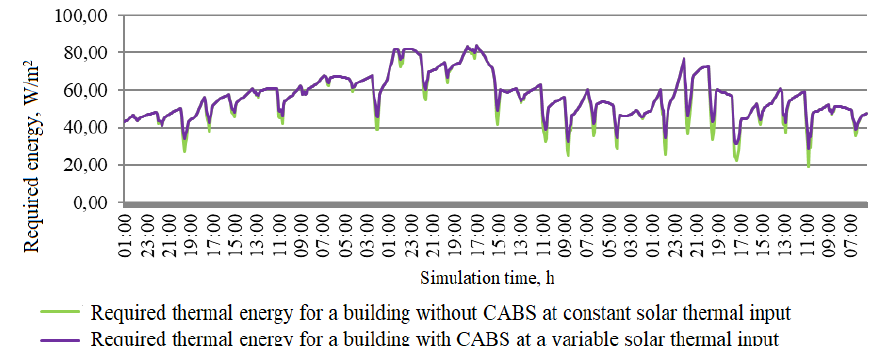
Fig. 2. Required energy with and without CABS in January month.